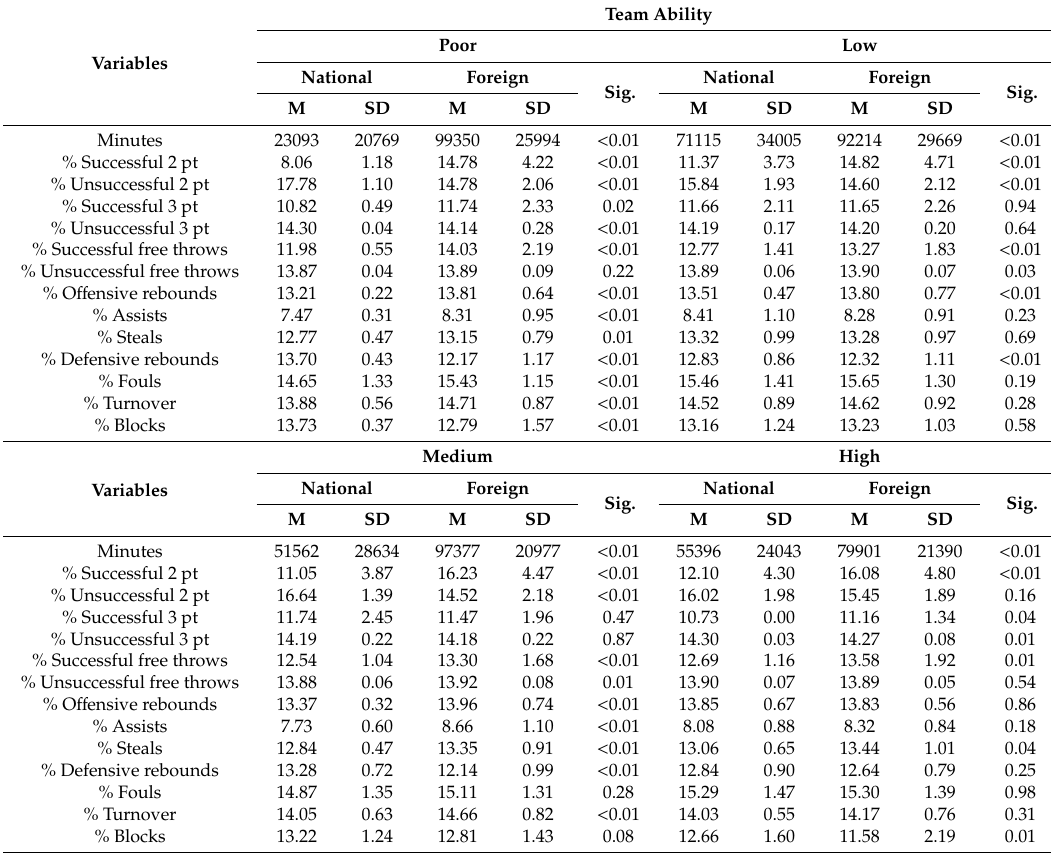
Table 3. Descriptive results (M, mean; SD, standard deviation) of national and foreign Centers based upon poor, low, medium, and high team